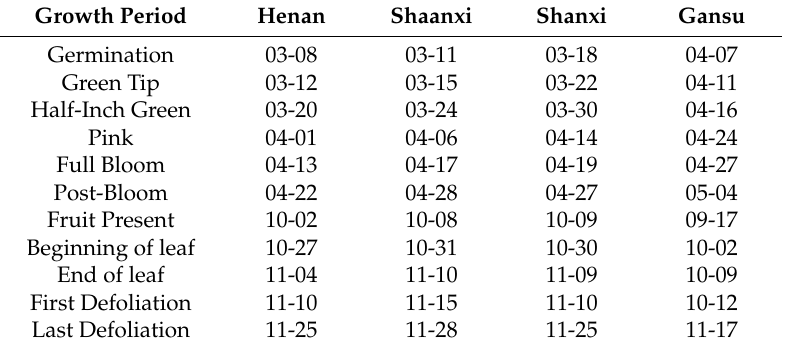
Table 1. The average growth period of apple tree in different subareas (month-day). Growth Period Henan